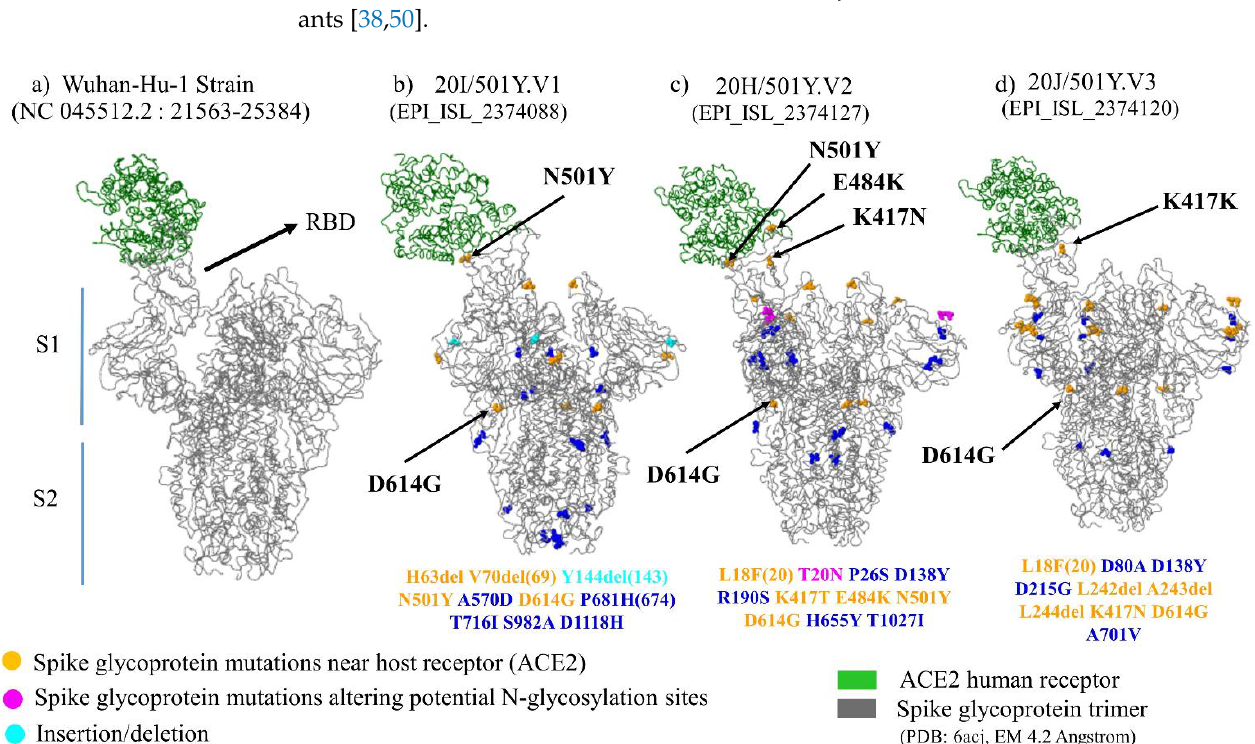
Figure 4. Tridimensional structure of Spike protein trimer in complex with host cell receptor ACE2. ( a ) 3D structure of Wuhan Strain Spike protein trimer; ( b ) 3D structure of Spike protein trimer of 20I/501Y.V1; ( c ) 3D structure of Spike protein trimer of 20H/501Y.V2; ( d ) 3D structure of Spike protein trimer of 20J/501Y.V3. S1 (Subunit 1); S2 (Subunit 2) [51].